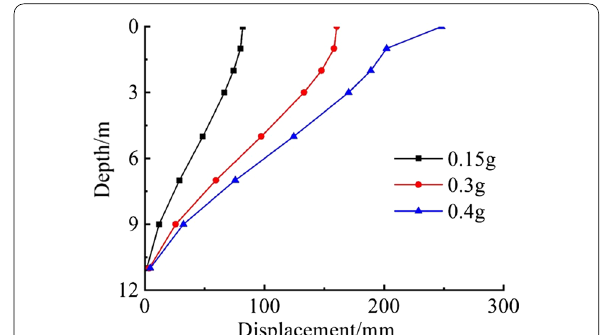
Fig. 13 Seismic subsidence at different soil depths due to El Centro ground motion with different PGA